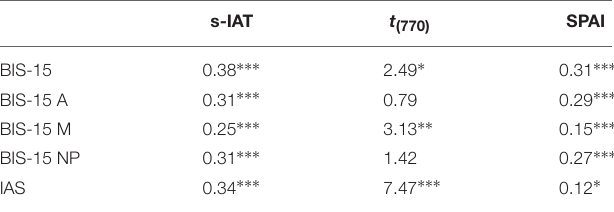
TABLE 4 | Correlations between impulsivity (BIS-15), social anxiety (IAS) and short internet addiction test (s-IAT)/smartphone addiction inventory (SPAI).